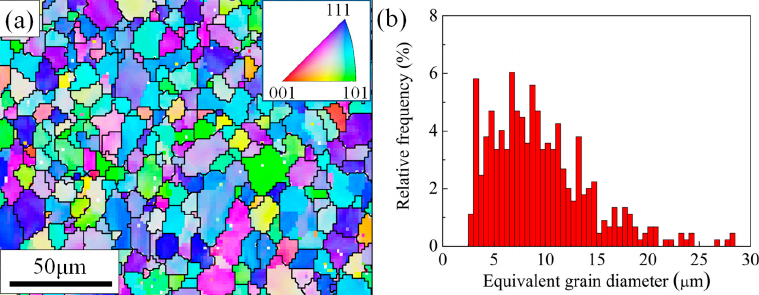
Figure 2. Electron backscattered diffraction (EBSD) results of the as-received NiTiFe shape memory alloy (SMA) by means of orientation imaging microscopy (OIM): ( a ) Microstructure; ( b ) histogram of equivalent grain diameter.